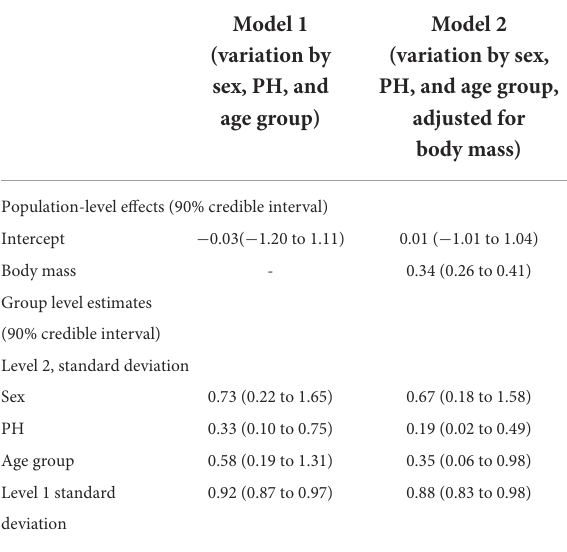
TABLE 4 Multilevel regression models posterior estimations and 90% credible intervals of variation in phase angle by sex, age group,